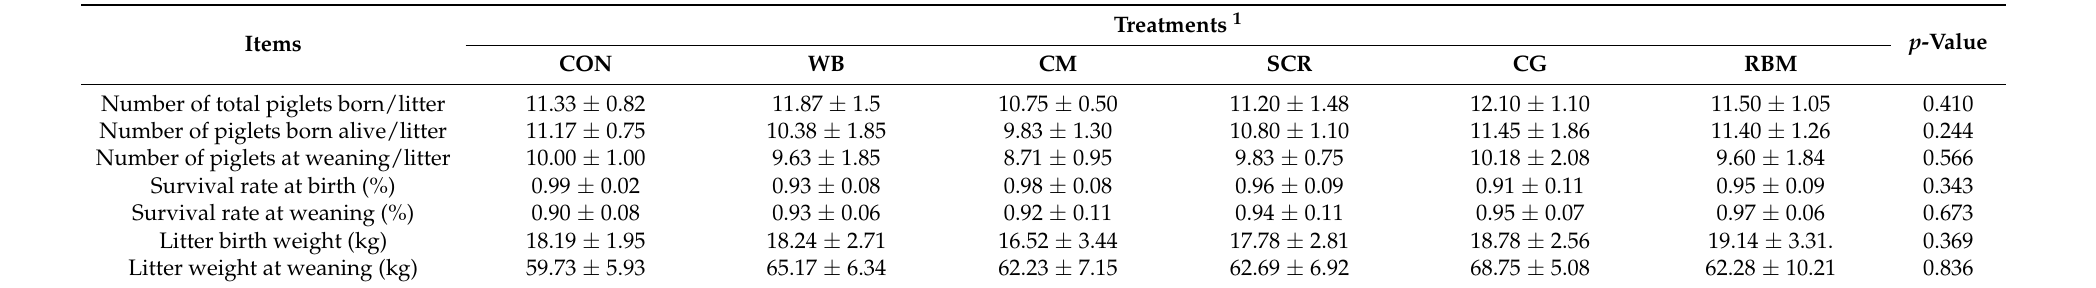
Table 4. Effects of different fiber sources on piglet